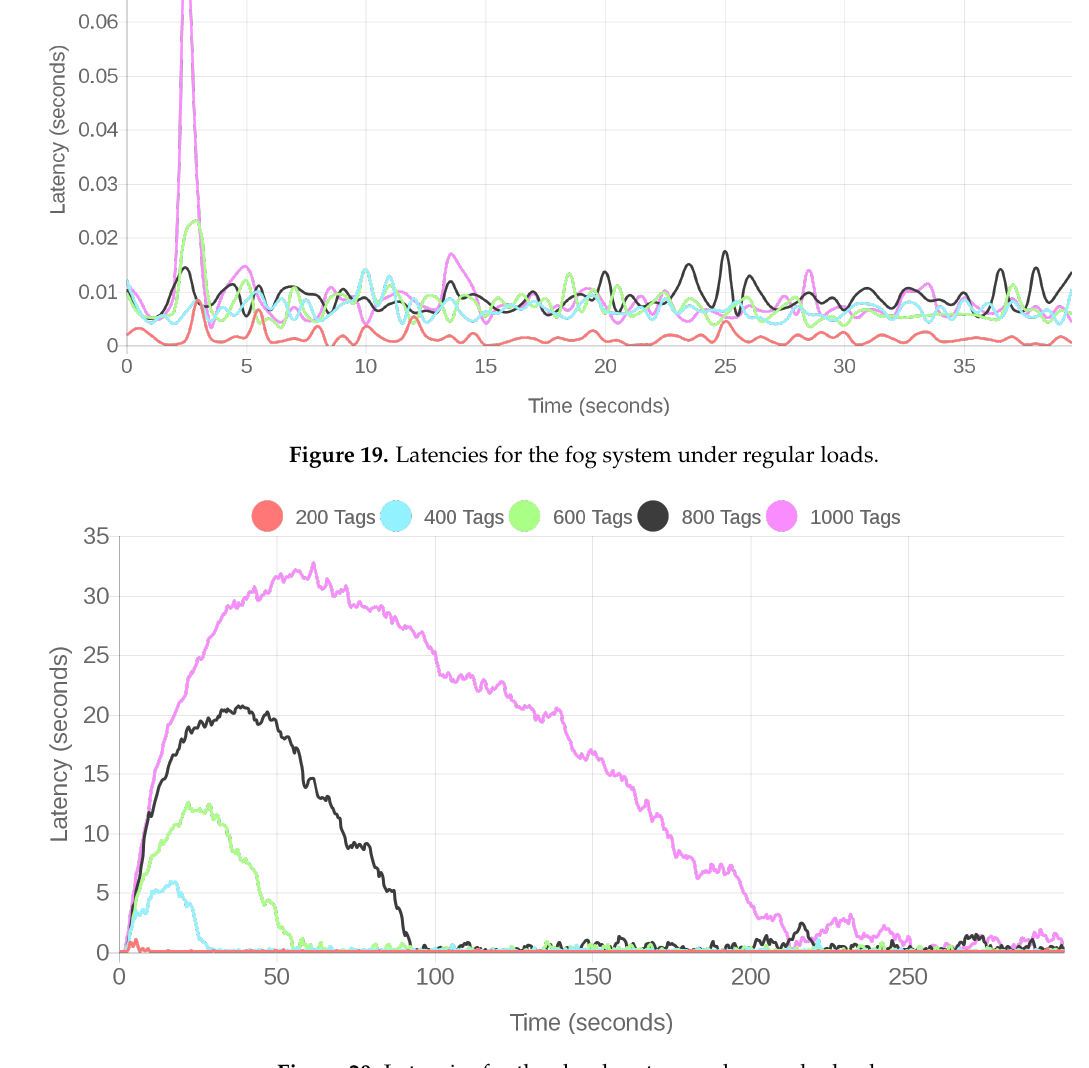
Figure 20. Latencies for the cloud system under regular loads. Table 2. Fog and cloud average latencies under regular loads (in